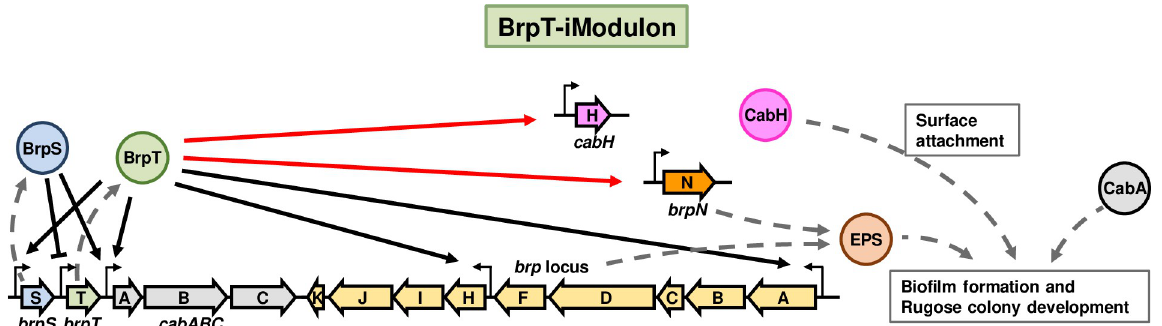
Fig 10. The transcriptional networks of BrpT. BrpT-iModulon contained cabH and brpN , the newly discovered genes in this study, in addition to brpS , cabABC , and the brp locus. Transcriptional regulator BrpT activates the expression of cabH , brpN , brpS , cabABC , and the brp locus. Transcriptional regulator BrpS activates the expression of cabABC and represses the expression of brpT . CabH is involved in the surface attachment and CabA is crucial for biofilm structural development. BrpN and the proteins expressed from the brp locus participate in the EPS biosynthesis. This sophisticated regulatory network elaborately controls robust biofilm and rugose colony development in V . vulnificus